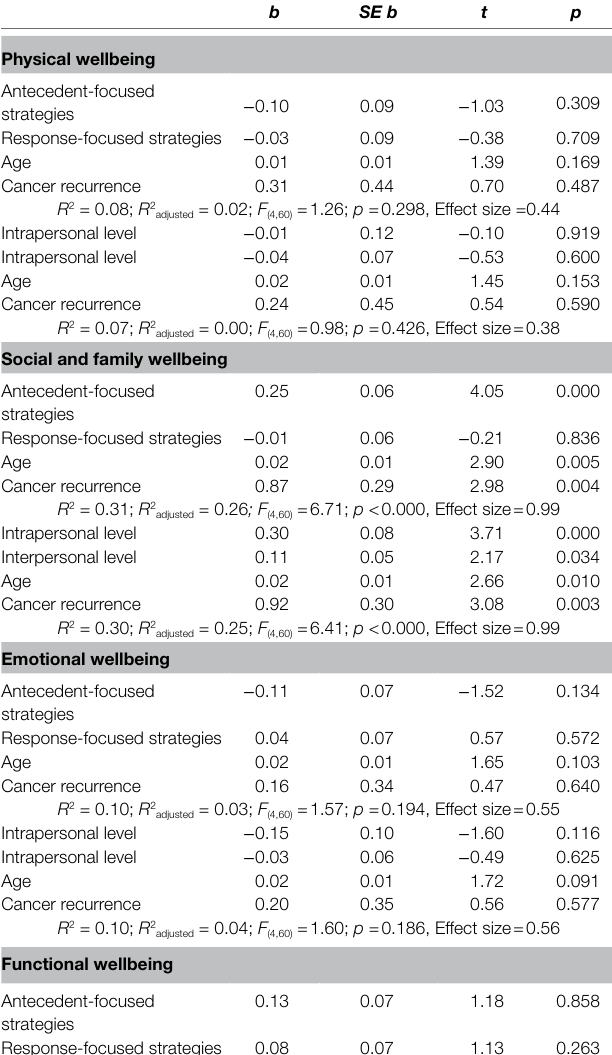
TABLE 4 | Regression analyses for quality of life measures by types of strategy and regulatory levels. b SE b t p Physical wellbeing Antecedent-focused strategies −